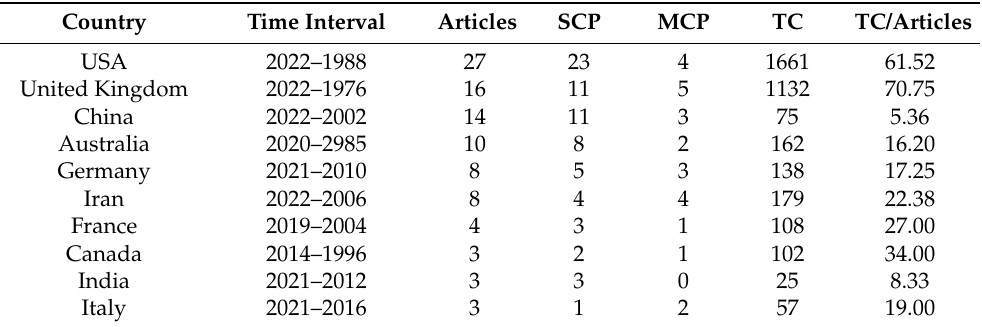
Table 2. Number of publications and citations of the 10 most productive countries in the period 1976–2022. SCP: Number of publications by country; MCP: Number of articles for the country, written in collaboration with other countries; TC: Total number of